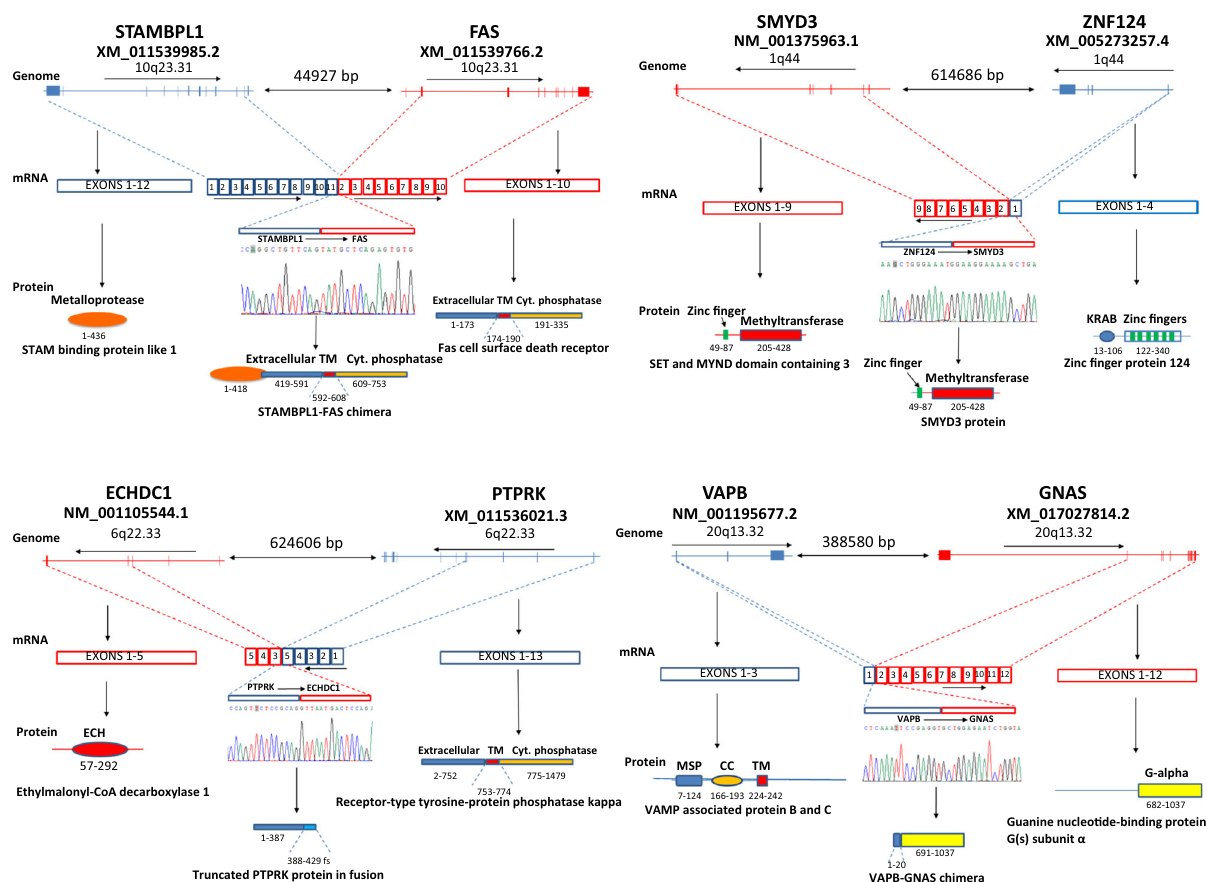
Fig. 5 Validation of previously unknown fusion gene isoforms identi fi ed in colon cancers through LoopSeq sequencing. A STAMBPL1-FAS fusion. Top: diagram of mini genomes of STAMBPL1 and FAS. Direction of transcription and distance between the two genes are indicated. Middle: mRNA represented by exons from each gene. Bottom: diagram of functional protein domains of STAMBPL1 and FAS. B ZNF124-SMYD3 fusion. Top: diagram of minigenomes of ZNF124 and SMYD3. Direction of transcription and distance between the two genes are indicated. Middle: mRNA represented by exons from each gene. Bottom: diagram of functional protein domains of ZNF124 and SMYD3. C PTPRK-ECHCD1 fusion. Top: diagram of minigenomes of PTPRK and ECHCD1. Direction of transcription and distance between the two genes are indicated. Middle: mRNA represented by exons from each gene. Bottom: diagram of functional protein domains of PTPRK and ECHCD1. D VAPB-GNAS fusion. Top: diagram of minigenomes of VAPB and GNAS. Direction of transcription and distance between the two genes are indicated. Middle: mRNA represented by exons from each gene. Bottom: diagram of functional protein domains of VAPB and